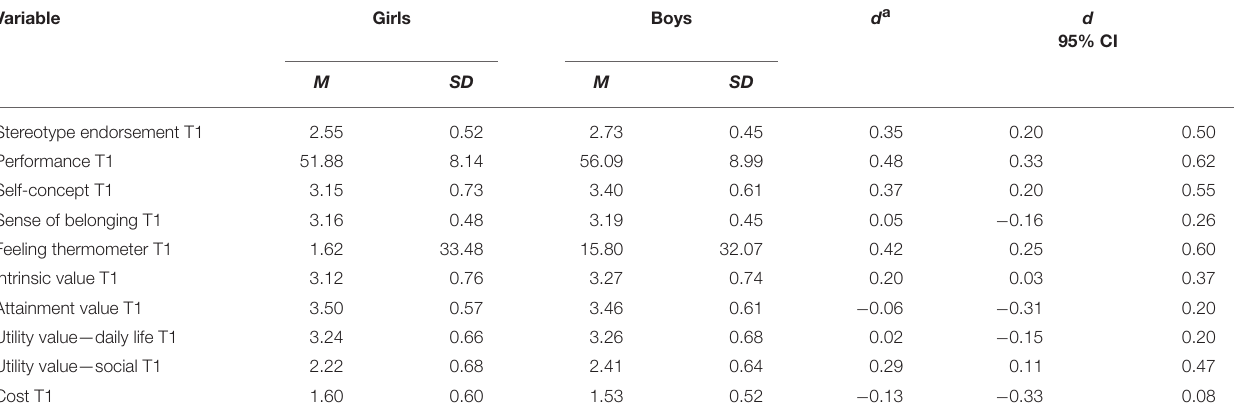
TABLE 1 | Descriptive statistics for all study variables on the pretest separated by gender.